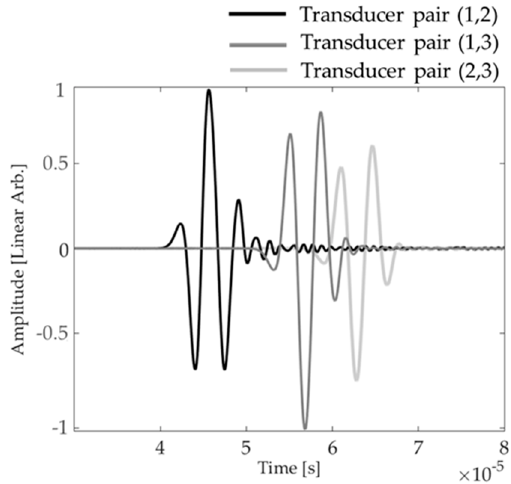
Figure 4. Example of subtracted signals containing a defect for all pairs of transducers.